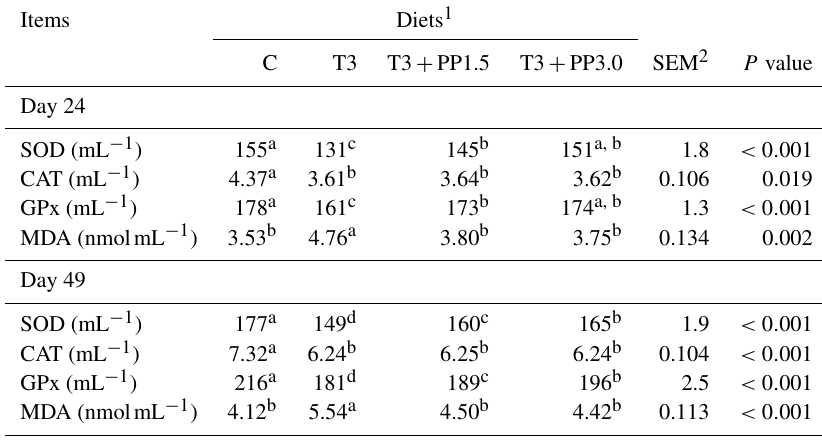
0.872 < 0 . 001 ALT (L − 1 ) 10.2 c 16.5 a 13.4 b 13.7 b 0.42 < 0 . 001 AST (L − 1 ) 317 b 458 a 457 a 452 a 11.1 < 0 . 001 LDH (L − 1 ) 90.2 < 0 . 001 a–c Means within row with different superscripts are significantly different ( P < 0 . 05 ); Tukey’s test was applied to compare means. 1 C, control (basal diet); T3, basal diet + 1 . 5mgkg − 1 T3; T3 + PP1.5, T3 + 1 . 5gkg − 1 purslane